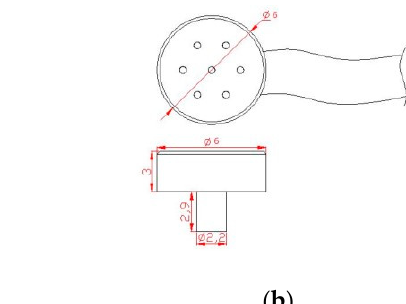
Figure 2. Schematic diagram of the experimental platform and experimental mode.